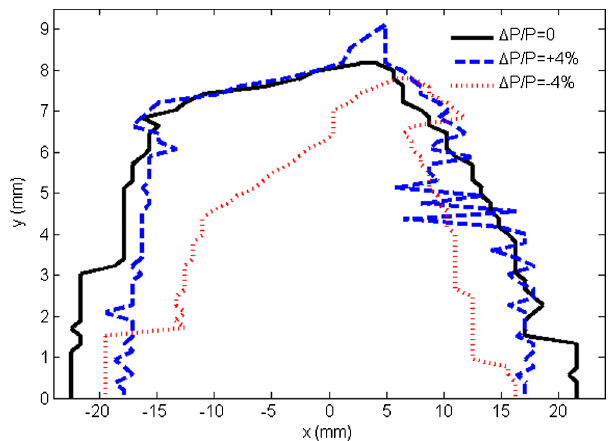
FIG. 4. The dynamic aperture at the center of the straight section. The horizontal/vertical chromaticity is corrected to 2 . 0 = 2 . 2 . The particle tracking has been done for 5000 turns passing through the storage